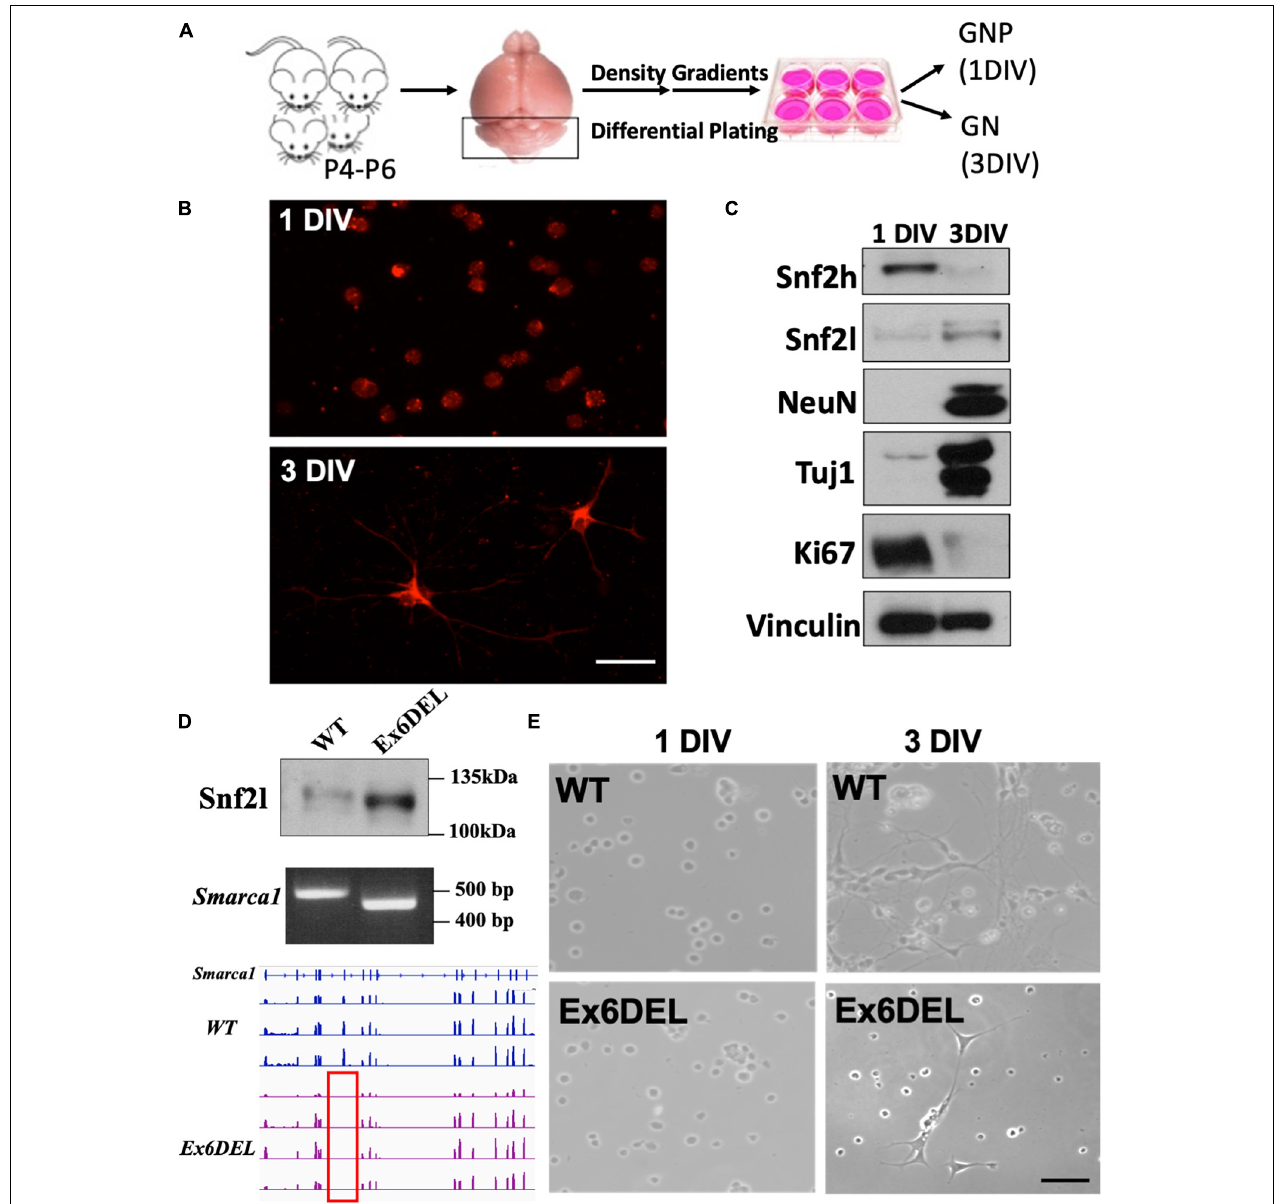
FIGURE 1 | Generation of GNP cultures from the Ex6DEL mice. (A) Schematic diagram of the procedure for generating GNP and granule neuron cultures. (B) Representative images of WT cultures 1 DIV (top image) and 3 DIV (bottom image) stained with neurofilament-200 (red). Scale bar, 25 µ M. (C) Protein extracts of primary GNP cultures at I and 3 DIV were immunoblotted for the ISWI proteins (Snf2h, Snf2l), neuronal (Tuj, NeuN) and proliferation (Ki67) markers. Vinculin was used as a loading control. (D) Immunoblot (top panel), Smarca1 genotyping (middle panel), and RNAseq analysis (bottom panel) from WT and Ex6DEL GNP cultures confirmed the loss of exon 6 in the GNP cultures isolated from Ex6DEL mice. The red rectangle outlines the absence of RNAseq reads corresponding to the position of exon 6. (E) Phase contrast images of GNP cultures from WT and Ex6DEL mice. Scale bar, 50 µ